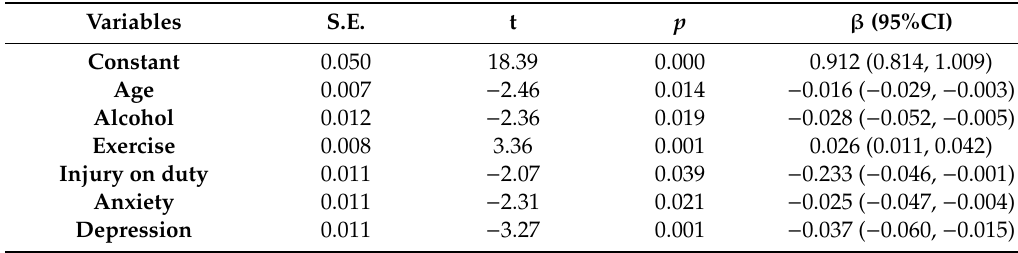
Table 5. The results of the Tobit regression on the EQ-5D-3L